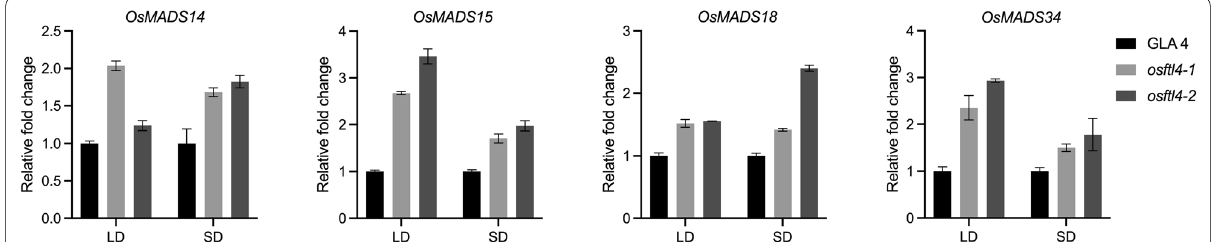
Fig. 4 Comparison of floral meristem identity gene transcription levels of the wild-type and mutant plants. OsMADS14 , OsMADS15 , OsMADS18 , and OsMADS34 expression levels in GLA 4 and osftl4 under LD and SD conditions. For all examined genes, the transcription level in GLA 4 was set at 1 (i.e., baseline). Each point represents three technical